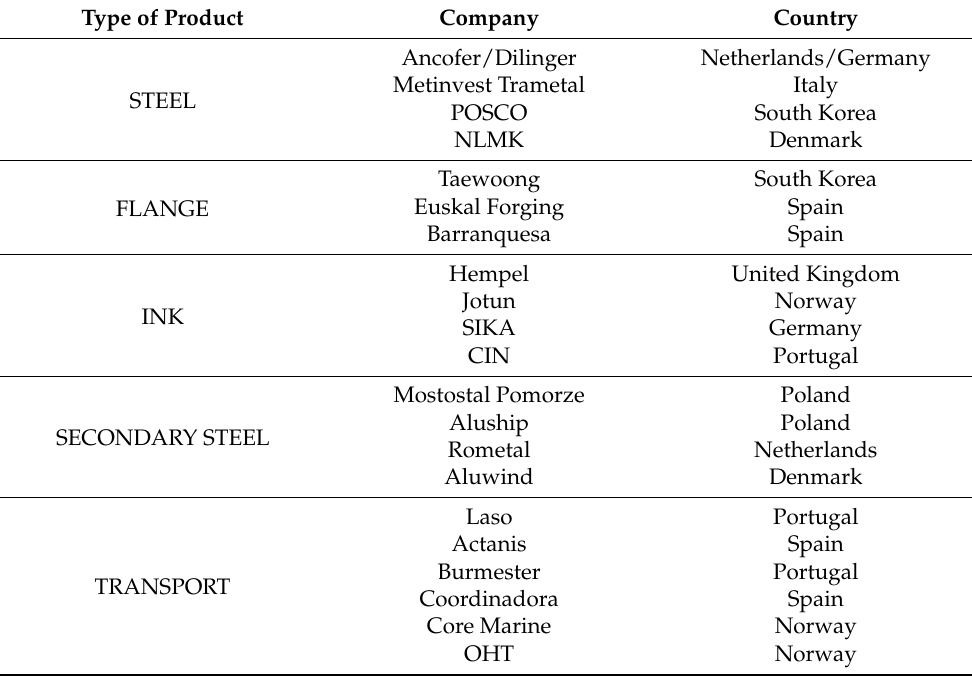
Table 6. Raw material suppliers for ASM